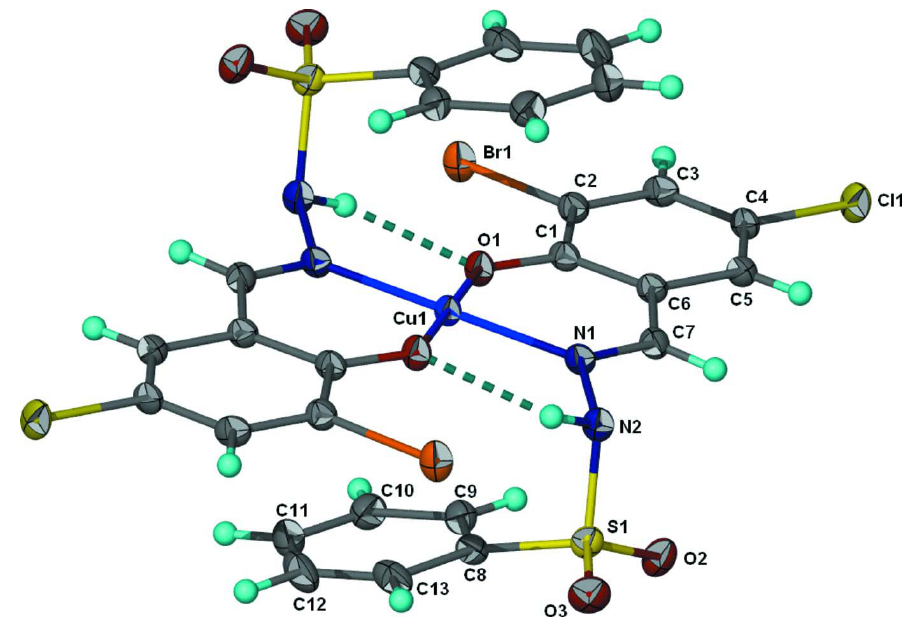
H BrClN O S) at the 70% probability level. Hydrogen atoms are 13 9 2 3 2